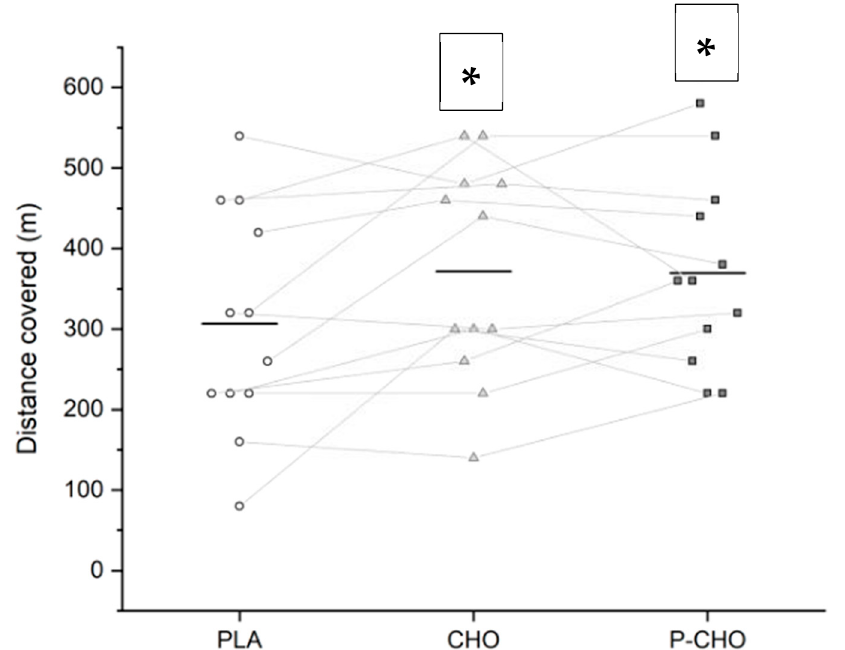
Figure 2. Distance covered during the high-intensity running performance test (Yo-Yo test) during PLA, CHO and P-CHO conditions. The line represents the mean. Individual distances are represented by white circles for PLA, grey triangles for CHO and black squares for P-CHO. * denotes a difference compared to PLA ( small ).